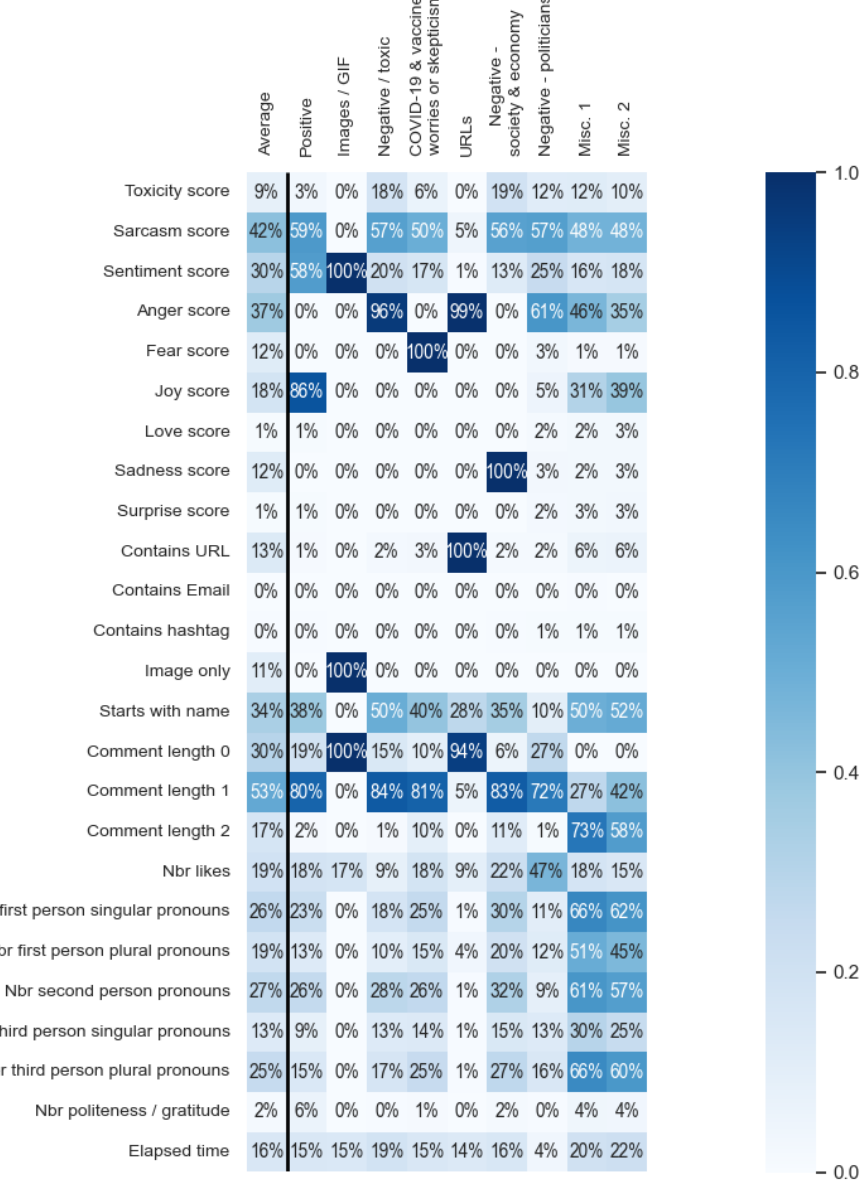
Figure 3. Heatmap of the emission probabilities of our